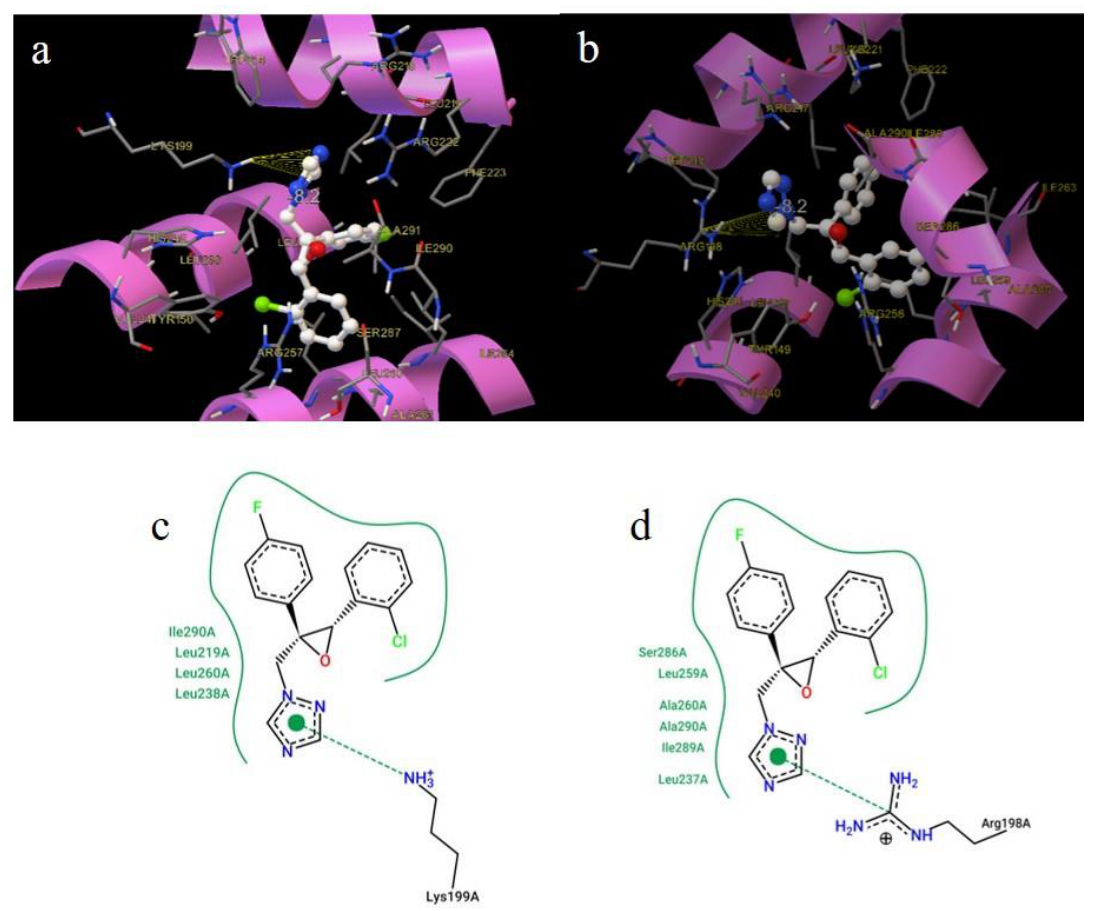
Figure 11. 3D reperesentations of epoxiconazole (EPX) in human serum albumin (HSA) ( a ) and bovine serum albumin (BSA) ( b ) Sudlow site I. 2D representations of EPX in HSA ( c ) and BSA ( d ) Sudlow site I.